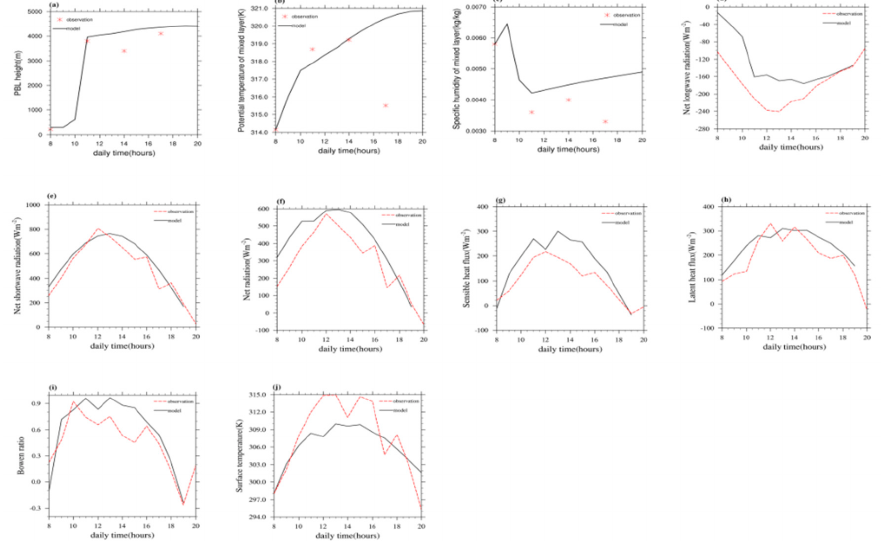
Figure 5. As in Figure 4, but for 9 July 2017, with soil saturation 0.19. ( a ): planetary boundary layer height ( b ): planetary boundary layer potential temperature ( c ): planetary boundary layer specific humidity ( d ): net longwave radiation ( e ): net shortwave radiation ( f ): net radiation ( g ): sensible heat flux ( h ): latent heat flux ( i ): Bowen ratio ( j ): surface temperature.